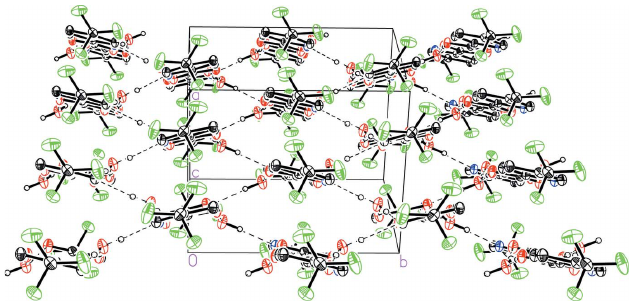
Figure 4 A view of the sheet hydrogen-bonding network in 5-(trifluorometh- yl)picolinic acid (I) hydrate viewing the water-bridge hydrogen-bonding dimers end-on shows the hydrogen-bonding interactions between the pleated strips forming a two-dimensional sheet.